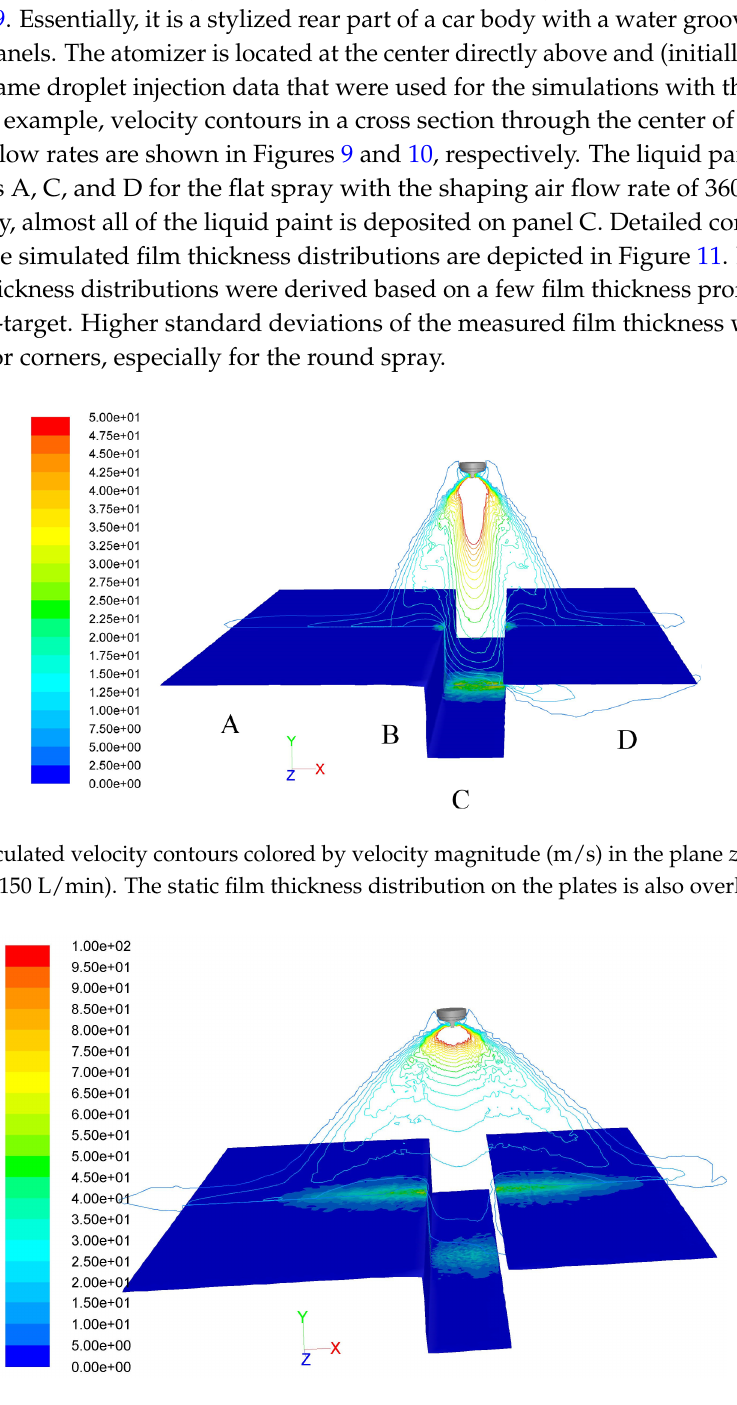
Figure 10. Calculated velocity contours colored by velocity magnitude (m/s) in the plane z = 0 (shaping air flow rate: 360 L/min). The static film thickness distribution on the plates is also overlaid.